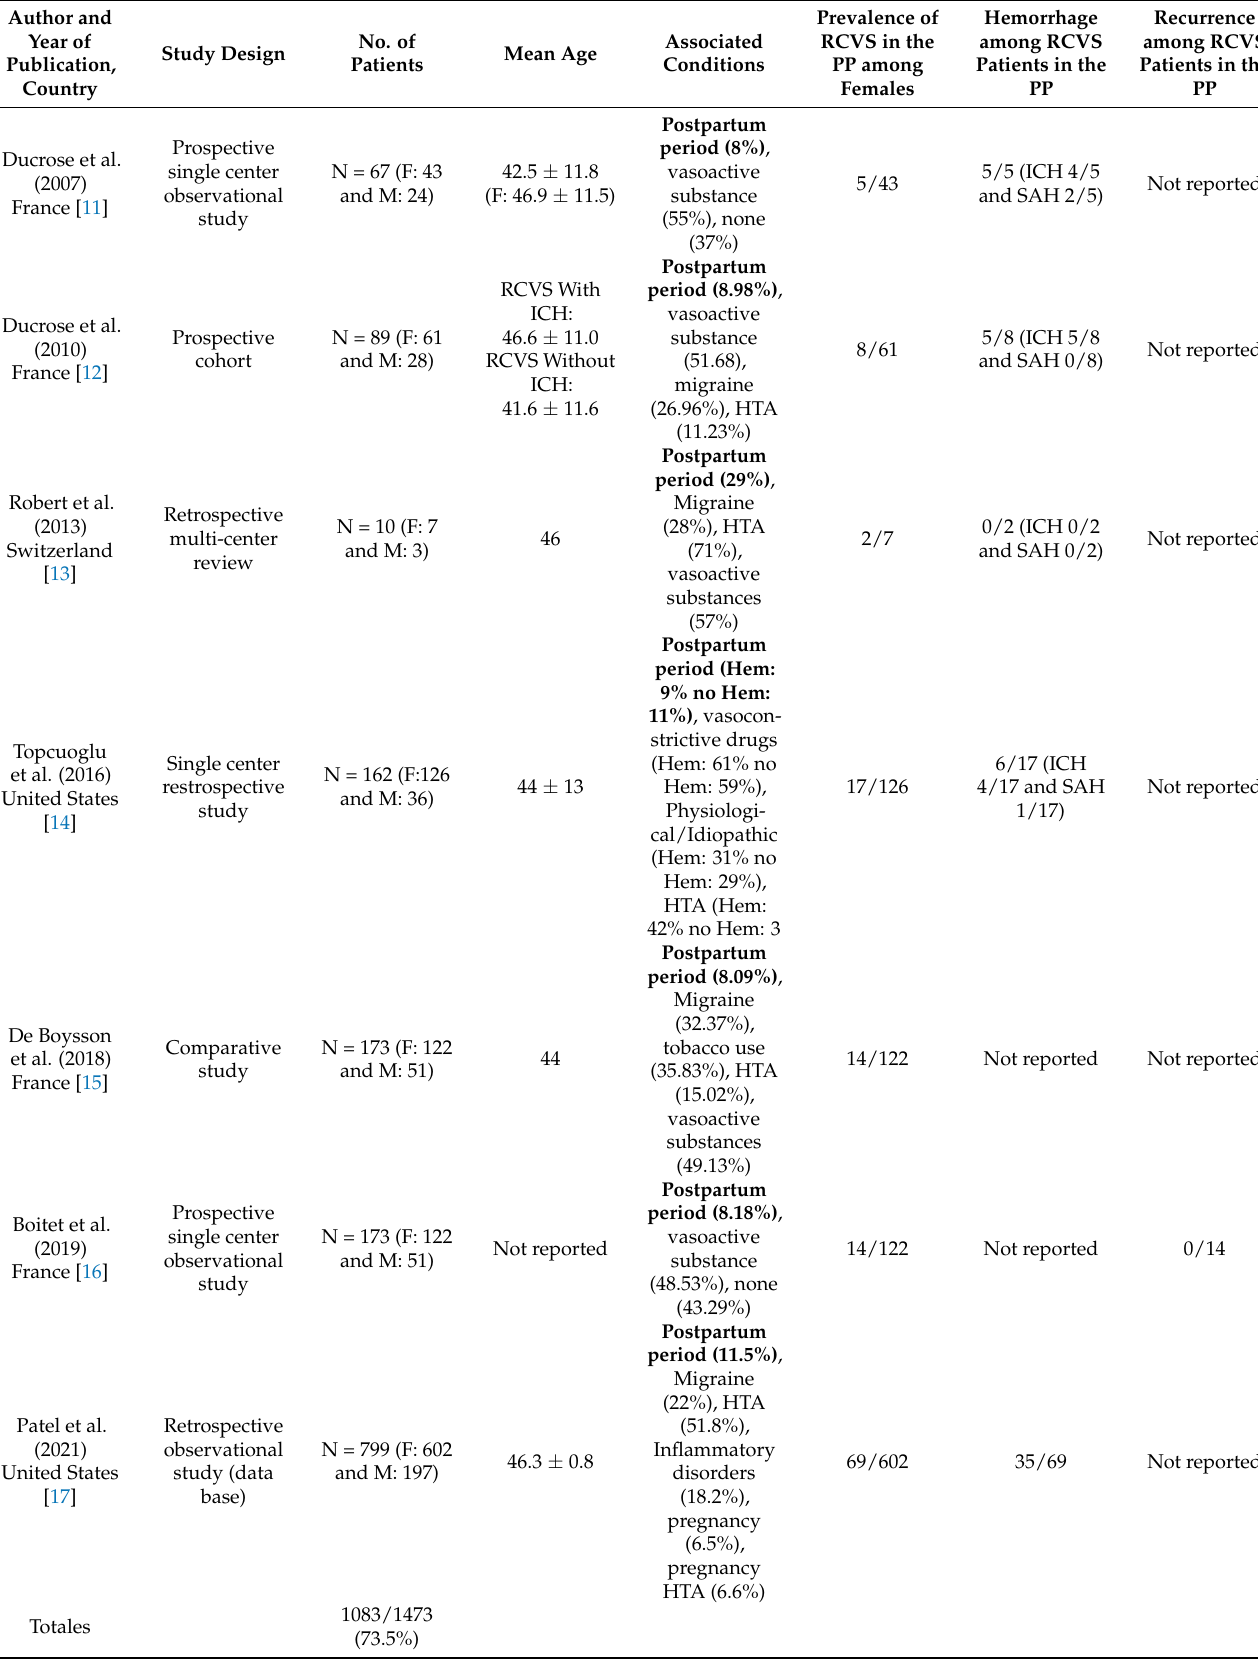
Table 1. The frequency of ICH, SAH, and Recurrence of RCVS among patients in the postpartum